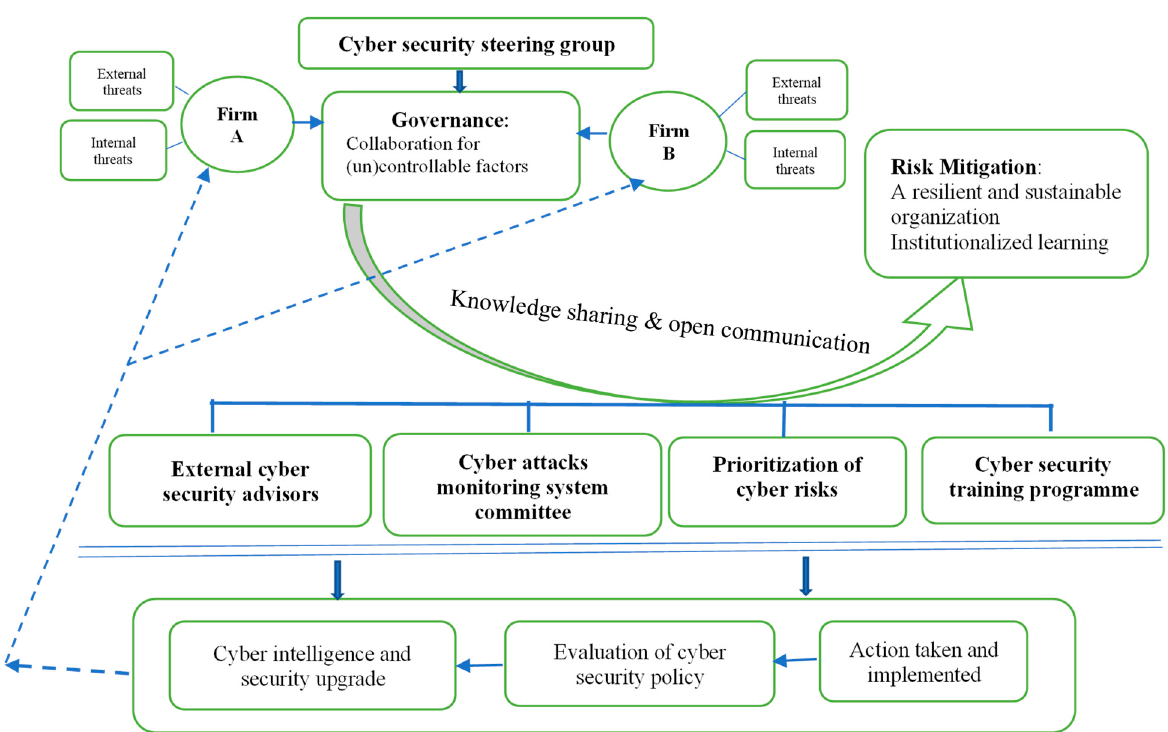
Figure 2. The global cyber security model.